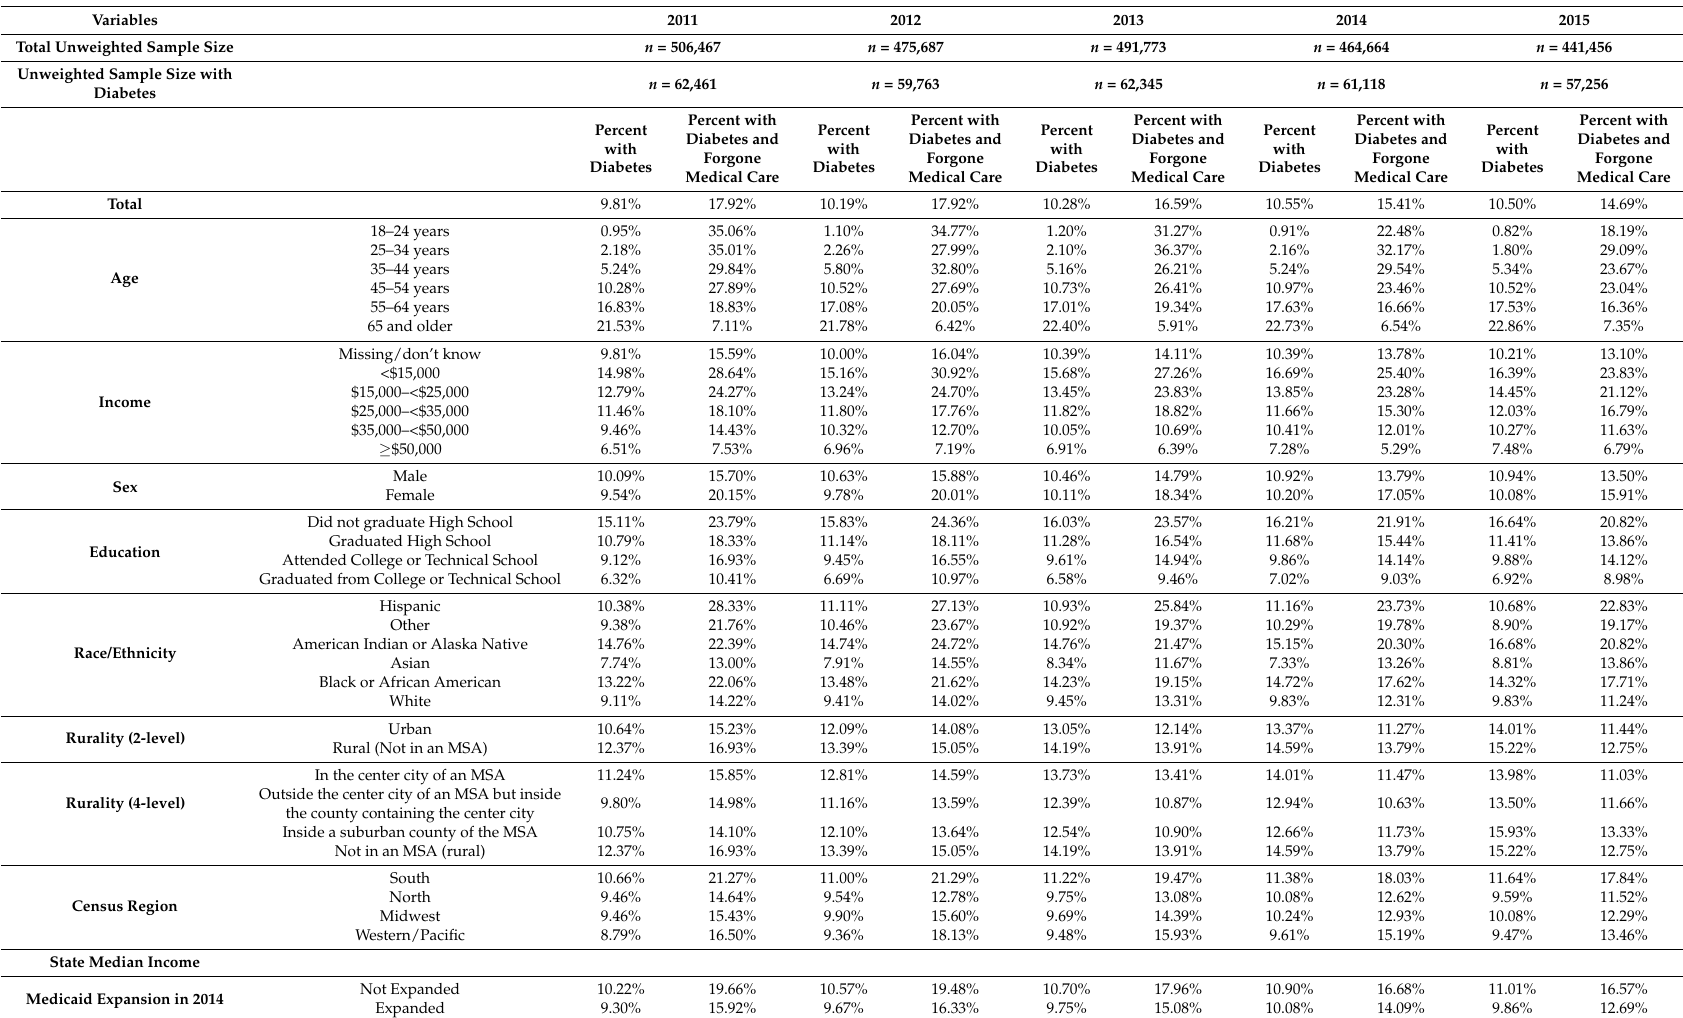
Table 1. Distribution of diabetes and forgone medical care throughout the U.S.,